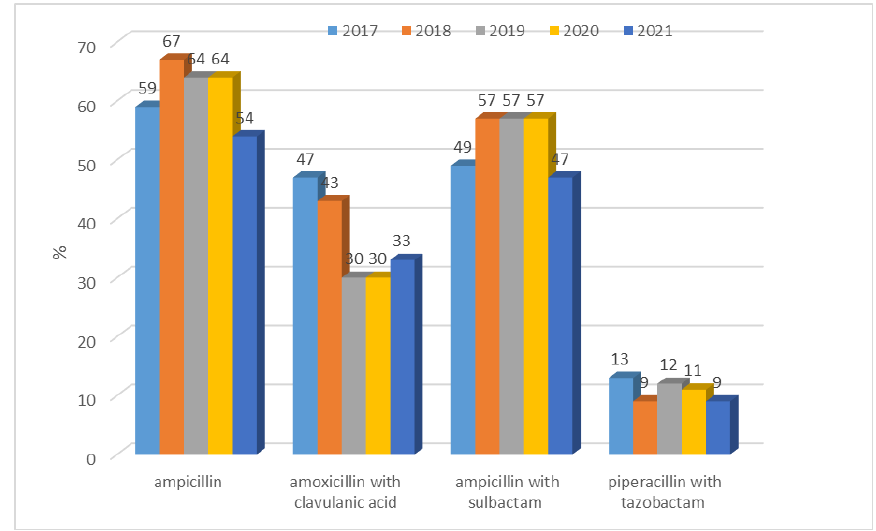
Figure 3. Percentage of E. coli ESBL(−) strains resistant to penicillins (ampicillin) and penicillins with inhibitors.